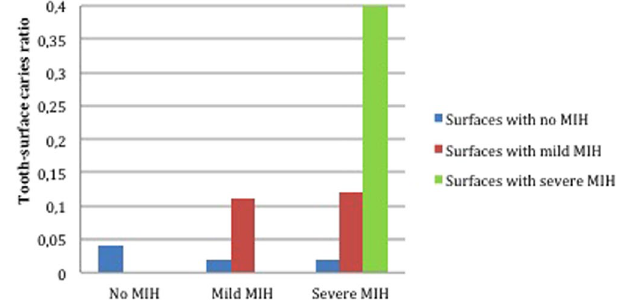
Figure 1. Tooth-surface caries ratio by hypomineralization level for each MIH group.